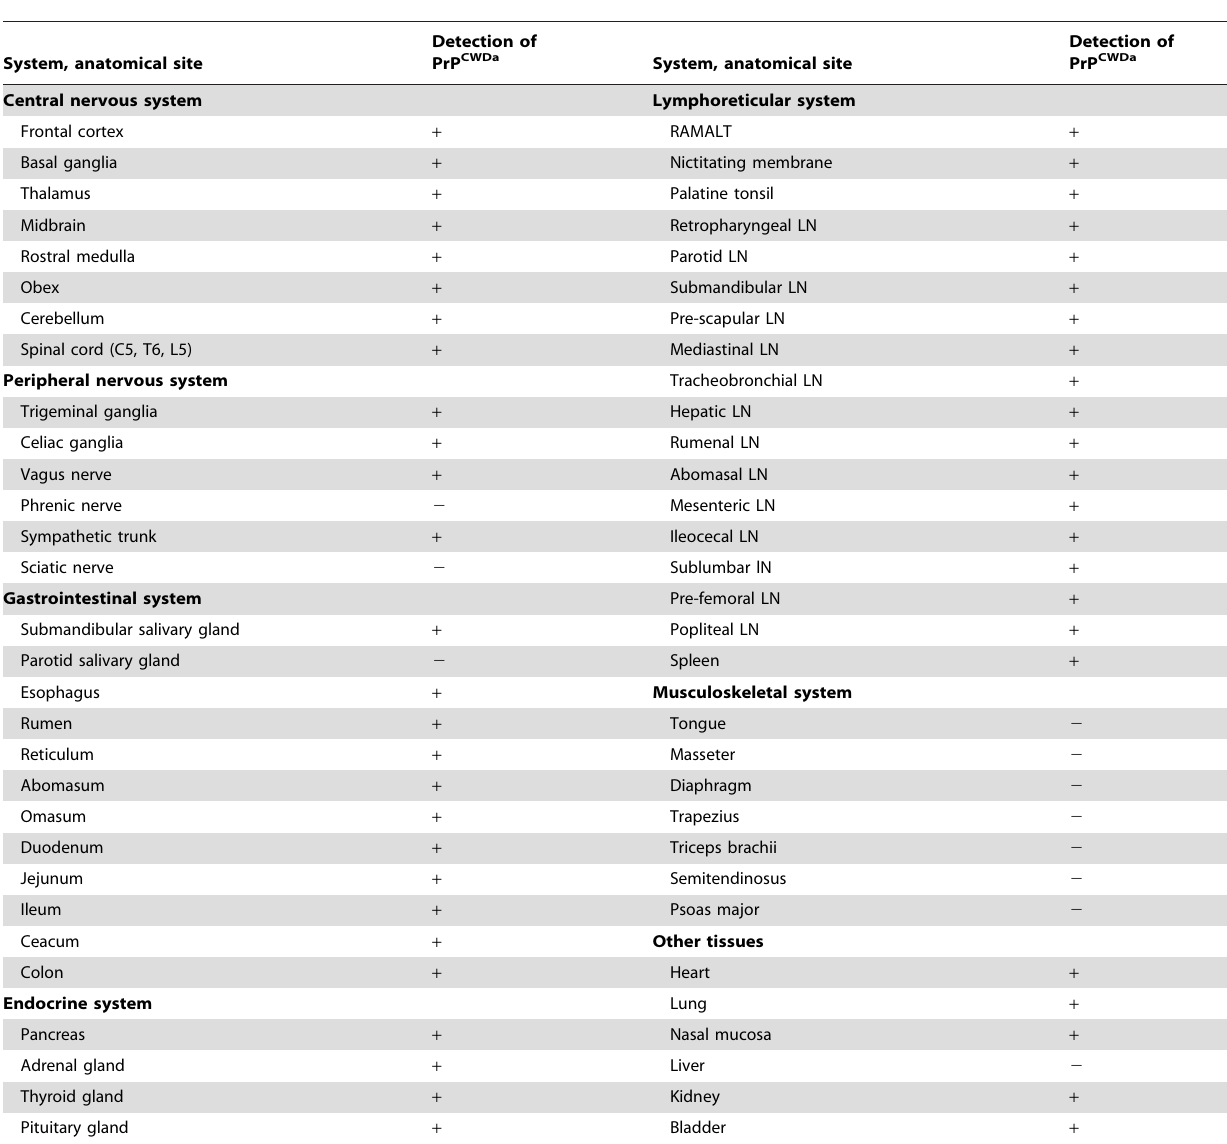
Table 2. PrP CWD distribution in tissues of reindeer orally inoculated with brain tissue from CWD-infected white-tailed deer.